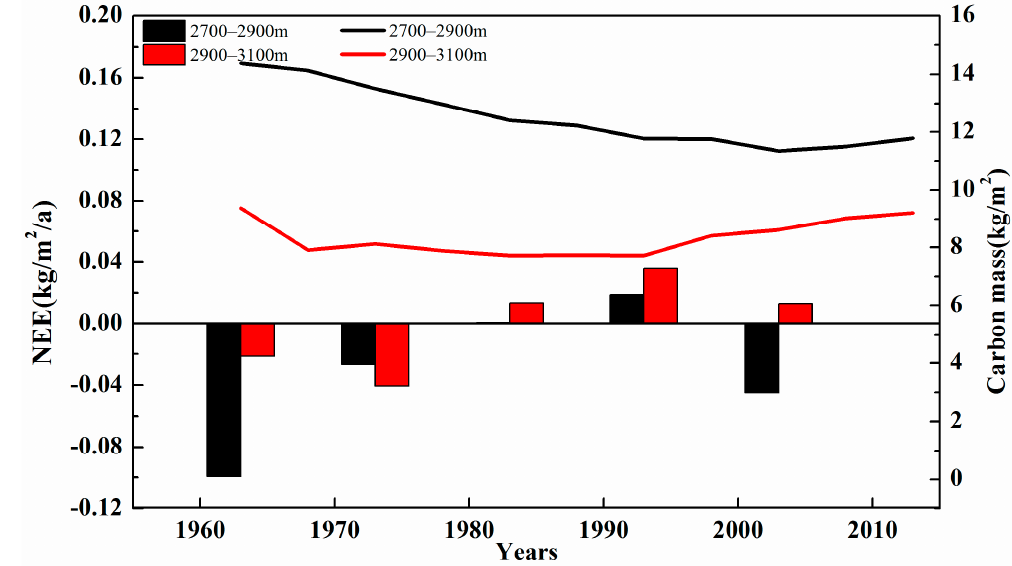
Figure 3. The carbon flows change in montane boreal forest ecosystem from 1964–2013. kg/m 2 /a: kg/m 2